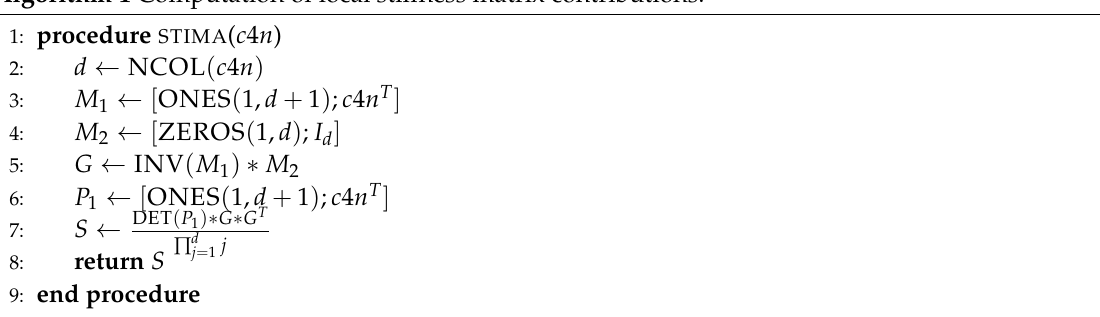
Algorithm 1 Computation of local stiffness matrix